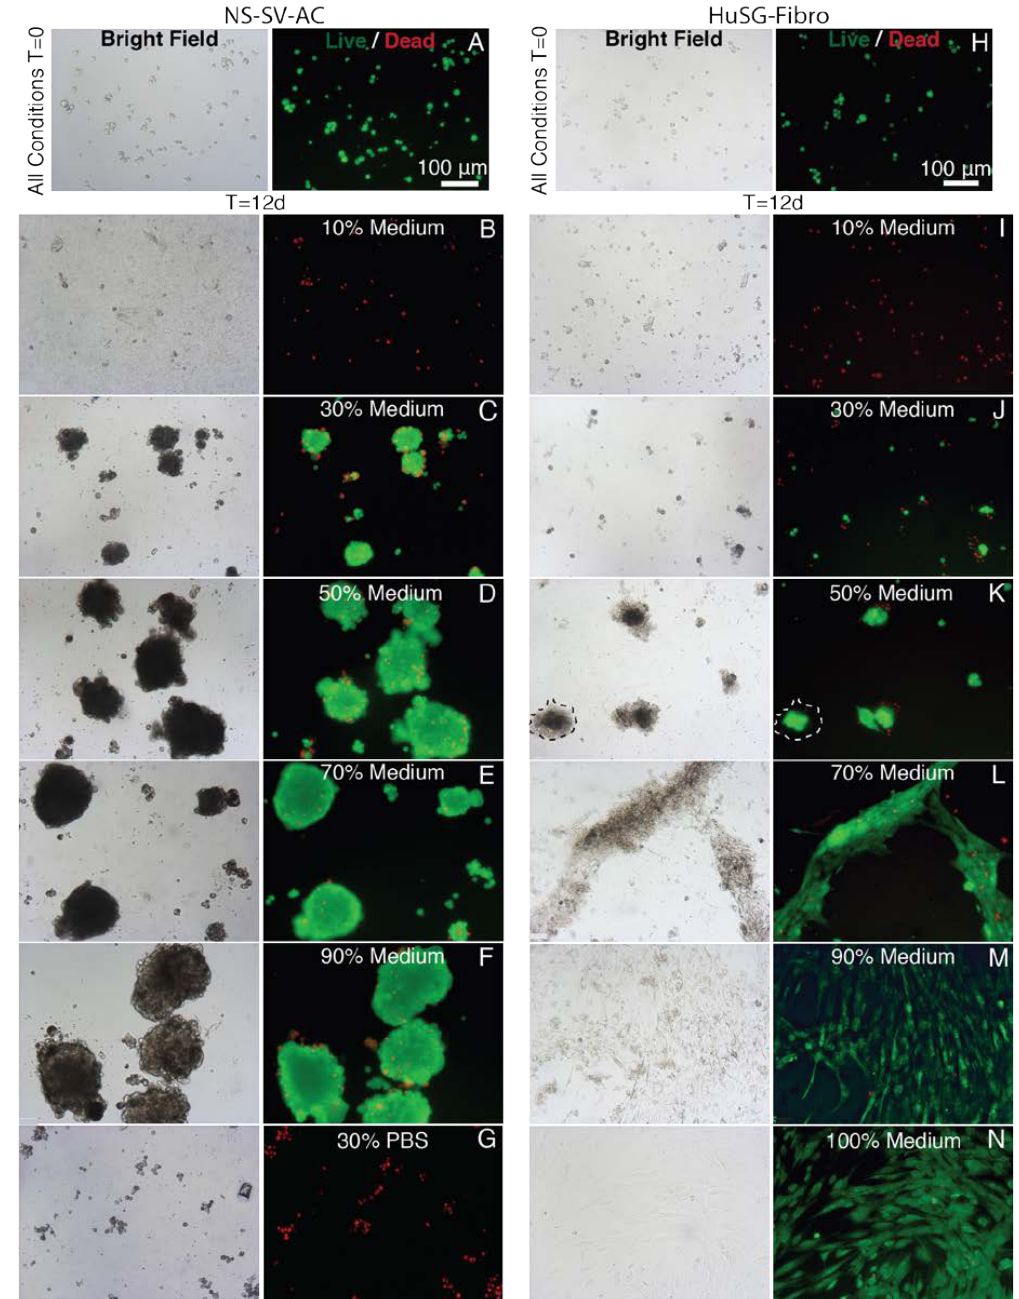
Figure A4. Bright Field and Fluorescent Images of NS-SV-AC and HuSG-Fibro Cells in EYP Cultures with Different Concentrations of Medium and Stained with Live/Dead. Representative images of the quantified data were imaged with a 10X objective inside wells of a 96 well plate (For the quantified data see Figure 2).